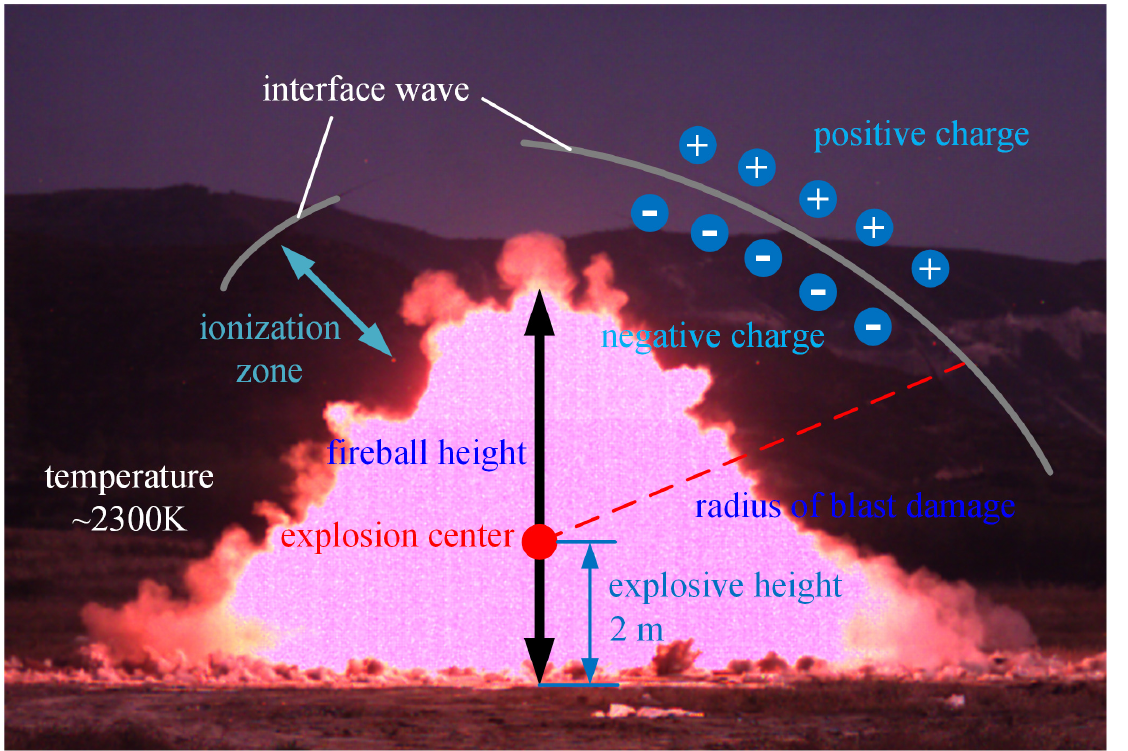
Figure 2. Schematic diagram of plasma changes caused by detonation at high temperature. As shown in Figure 2, it can be seen from Equation (1) that for a reaction system in an equilibrium state, the free energy of the system should satisfy the relationship shown in Equation (4), where F is the free energy, N represents the number of various particles in the system, N e represents the neutral atom, N + means positive ion, and N − means